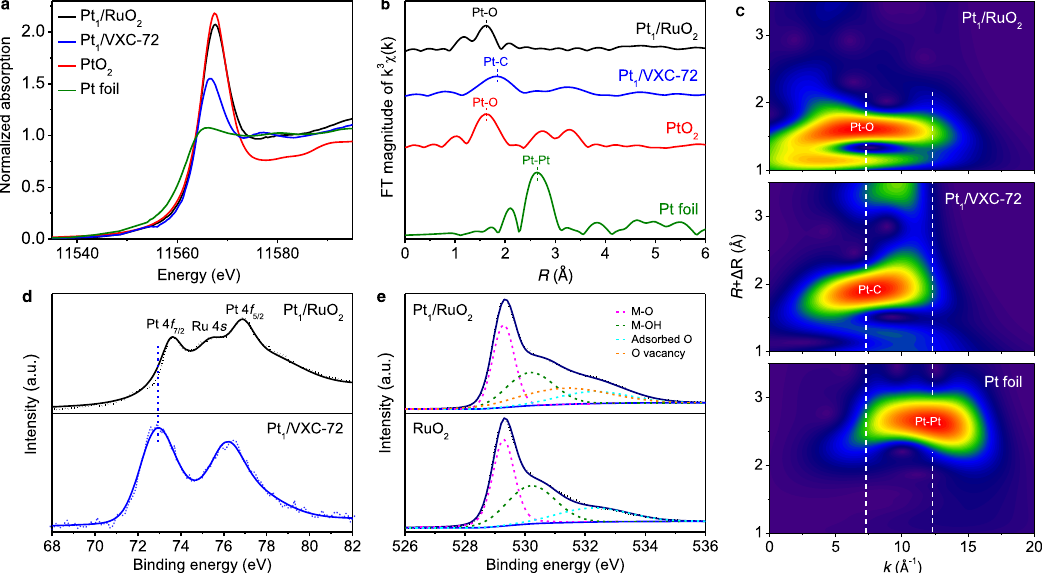
Fig. 2 Structural characterization of Pt 1 /RuO 2 and Pt 1 /VXC-72 by XAFS and XPS. a Normalized XANES spectra at the Pt L 3 -edge. b k 3 -weighted R-space Fourier transformed spectra from EXAFS. c Wavelet transforms from experimental data. d XPS spectra for Pt 4 f and Ru 4 s . e XPS spectra for O 1 s . In panels ( a – c ) and ( e ), the corresponding data for Pt foil, PtO 2 , and RuO 2 are presented for